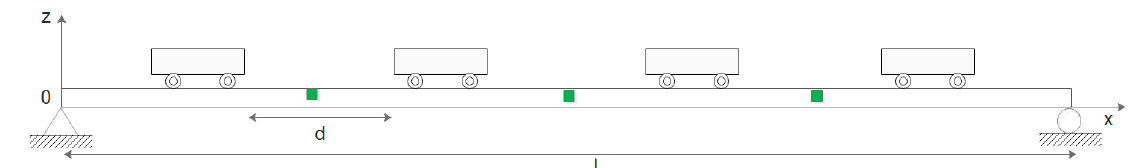
Figure 27. A simply supported beam subjected to moving inertial loads with a single span.